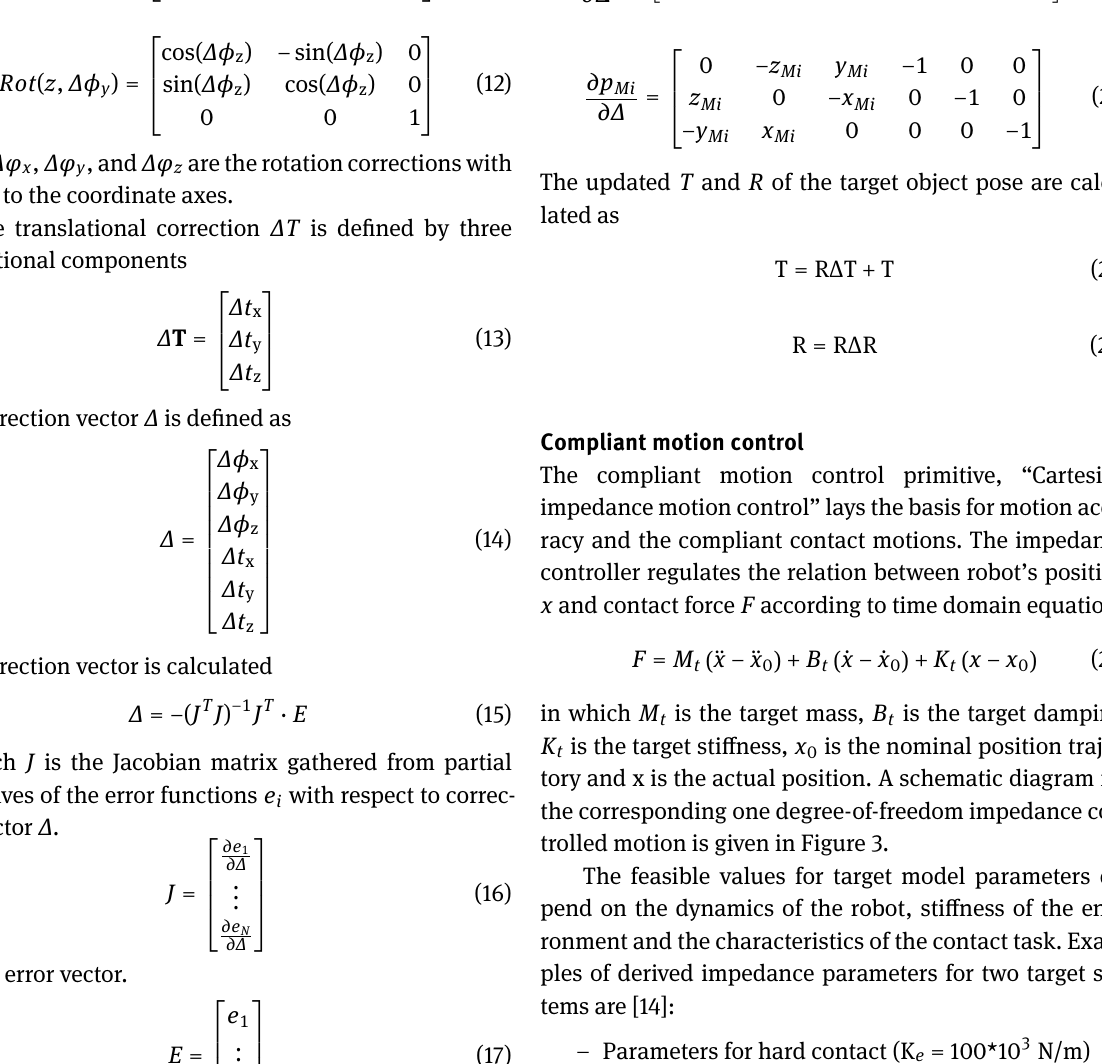
the corresponding one degree-of-freedom impedance con- trolled motion is given in Figure 3. The feasible values for target model parameters de- pend on the dynamics of the robot, stiffness of the envi- ronment and the characteristics of the contact task. Exam- ples of derived impedance parameters for two target sys- tems are